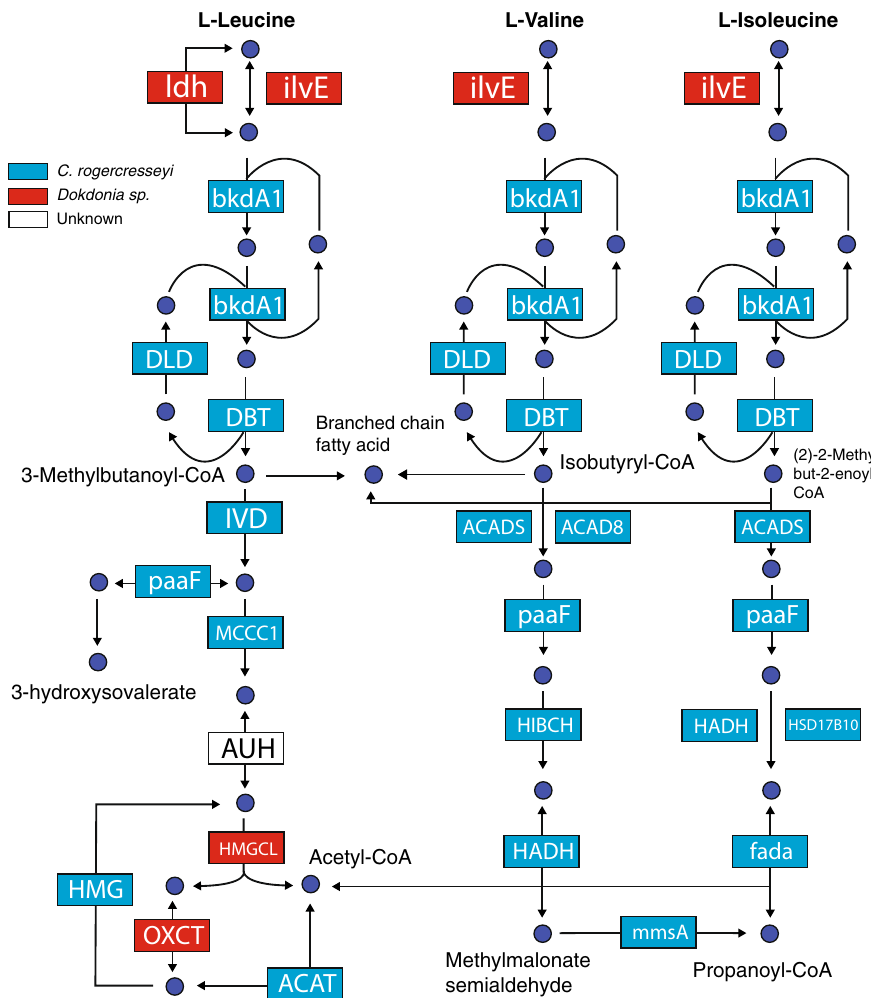
Figure 4. Metabolic reconstruction of the leucine, valine and isoleucine metabolism. Each box represents a gene coding for a protein in the pathway, where the blue boxes represent genes found in C. rogercresseyi genome and the red boxes genes found just in Dokdonia sp.